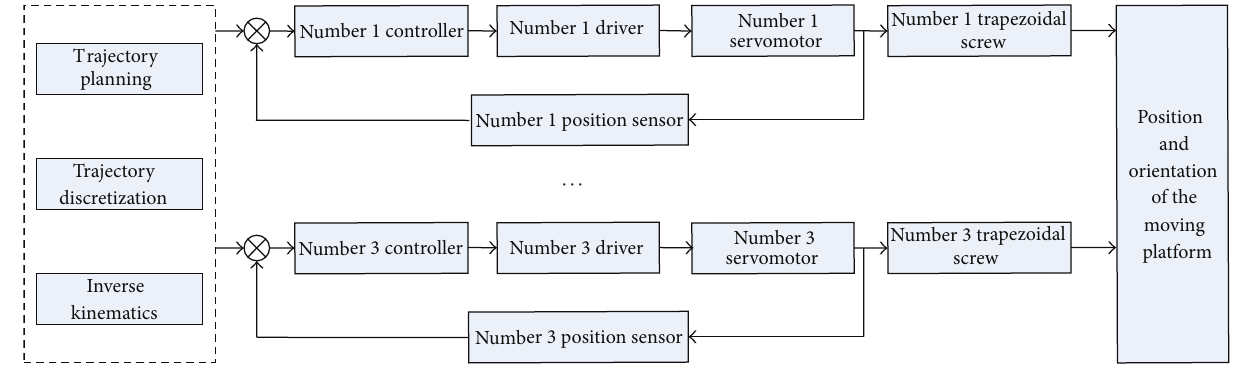
Figure 9: Control block diagram in the joint space.